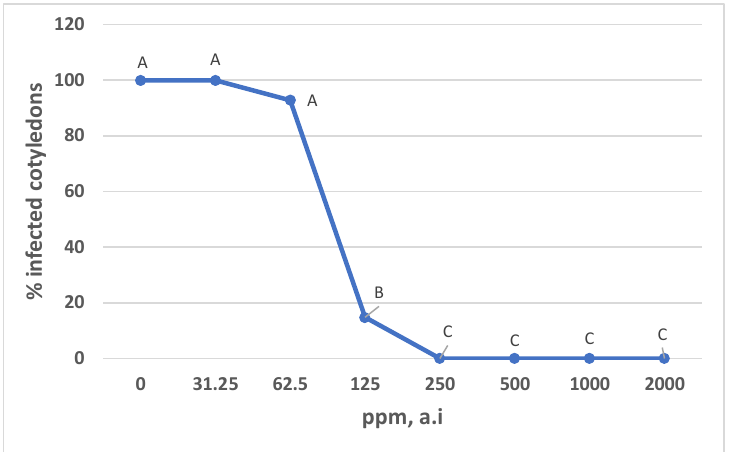
Figure 1. Efficacy of preventively applied Timorex Gold on the development of Bremia lactucae in lettuce cotyledons. Different letters on curves indicate a significant difference between means at p < 0.05.